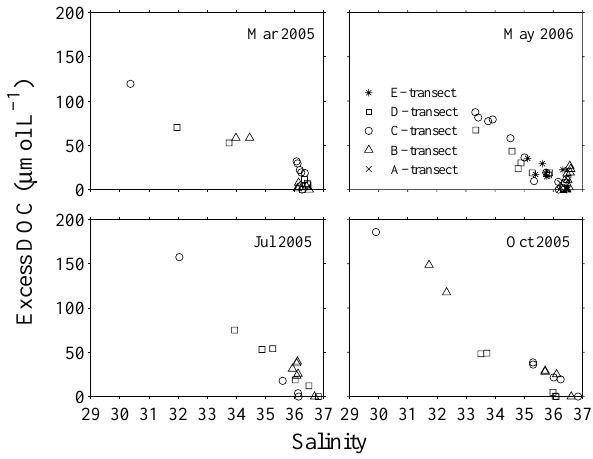
Fig. 12. Surface water excess DOC (i.e., DOC in excess of that from oceanic sources) vs. salinity in March, July, October 2005 and May 2006 in the South Atlantic Bight. Due to a lack of data, excess DOC in January and December 2005 was not